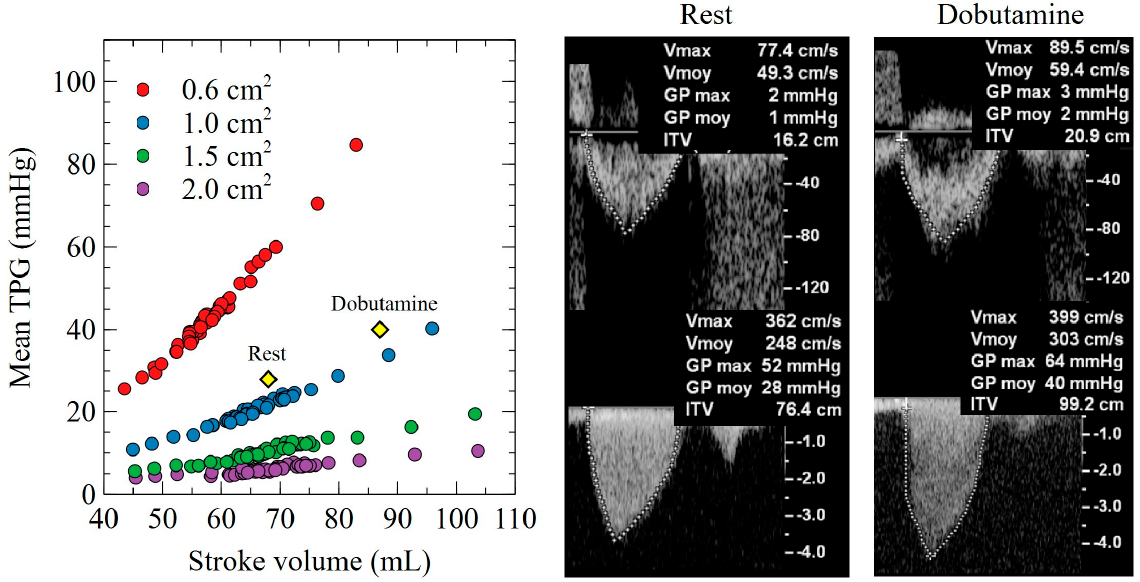
Figure 5. Association between SV and mean TPG for different levels of AVA. Echocardiographic evaluation of a patient with severe aortic stenosis at rest and after dobutamine infusion (12.5 ug/min/kg). The myocardial recruitment observed after dobutamine leads to an increase in stroke volume (from 67 mL to 87 mL) with a concomitant increase in mean TPG (from 28 mmHg to 40 mmHg). The AVA remained stable, suggesting a true severe aortic valve stenosis (AVA 0.88 cm 2 for an LVOT diameter measured at 23 mm). Model predictions were accurate for both rest and dobutamine hemodynamic conditions.